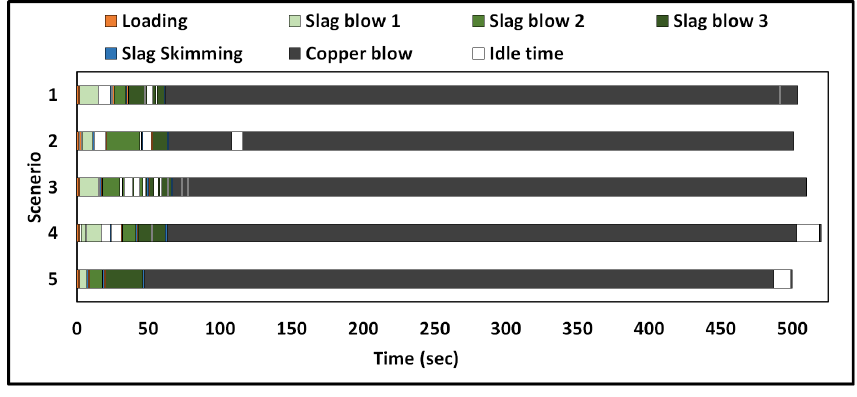
Figure 7. PSC schedule.